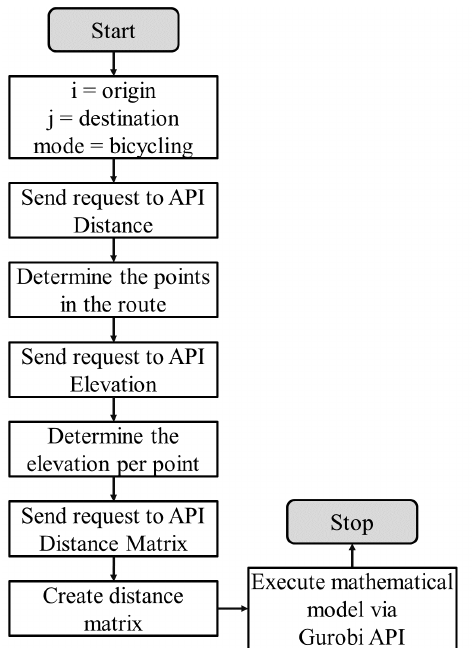
Figure 4. Road slope acquisition